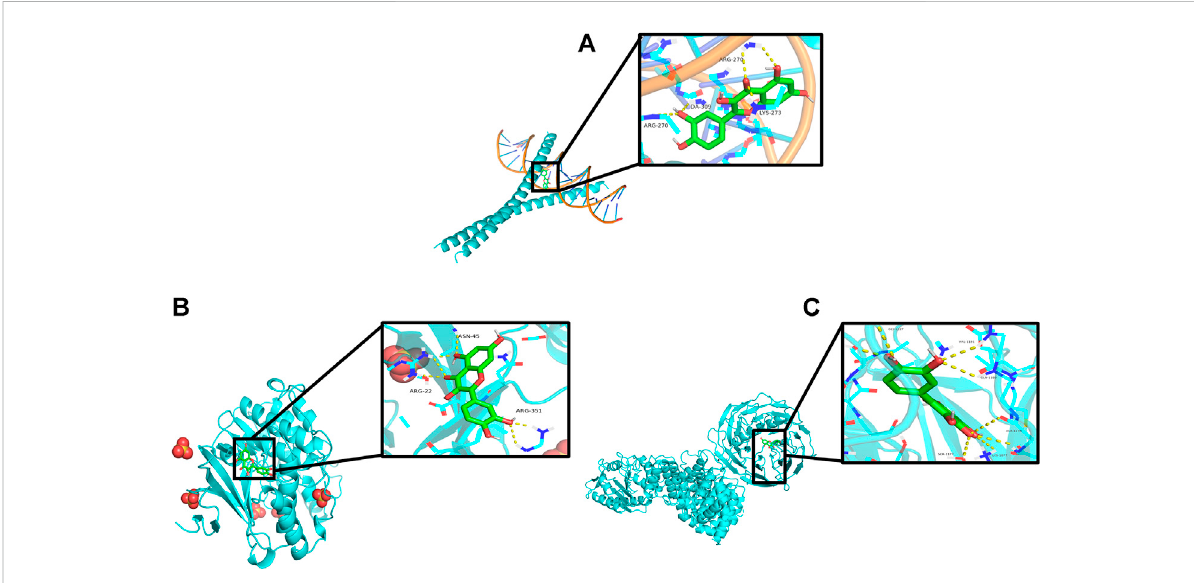
FIGURE 9 Schematicdiagramofquercetindockingwithcoretargets. (A) JUNdockingwithquercetin. (B) MAPK1dockingwithquercetin. (C) AKT1docking with